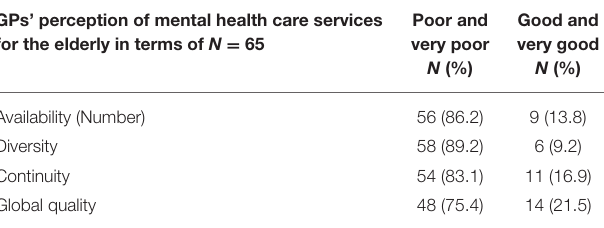
TABLE 2 | GPs’ perception of mental health care services for the elderly in terms of availability, diversity, continuity, and global quality.